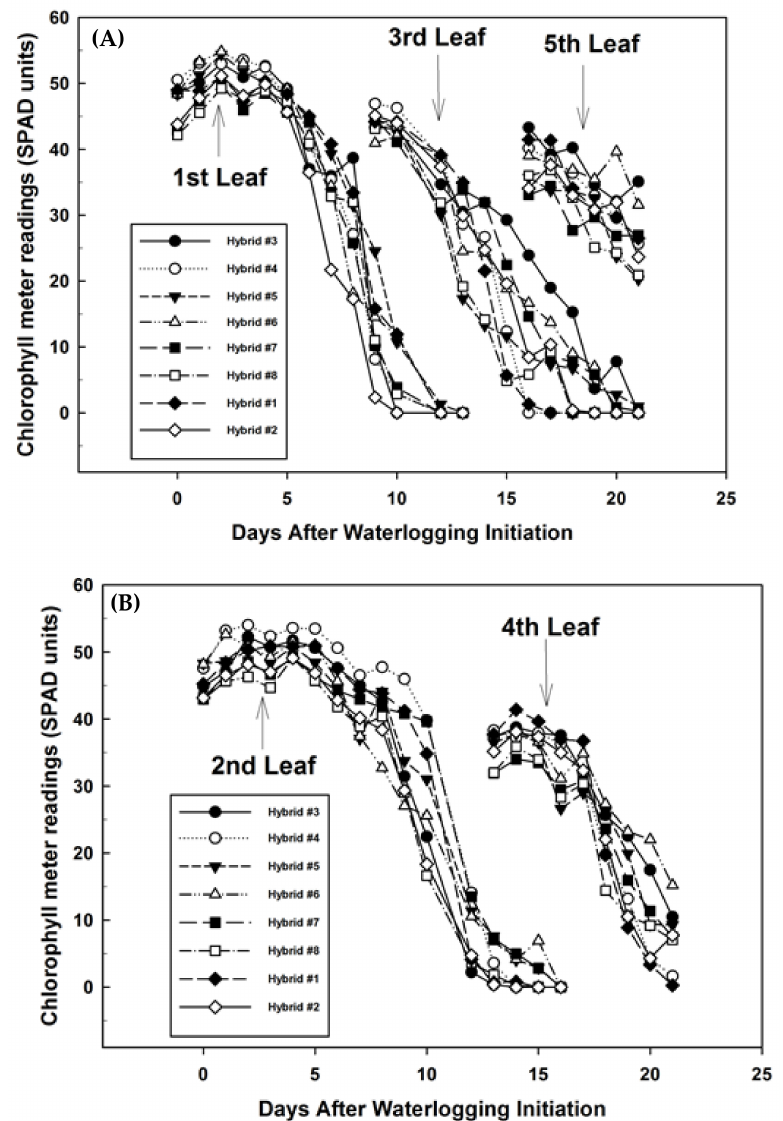
Figure 5. Changes in chlorophyll meter readings for first, third, and fifth leaf ( A ) and for second and fourth leaf ( B ) among different corn hybrids as affected by days of waterlogging in 21-day waterlogging